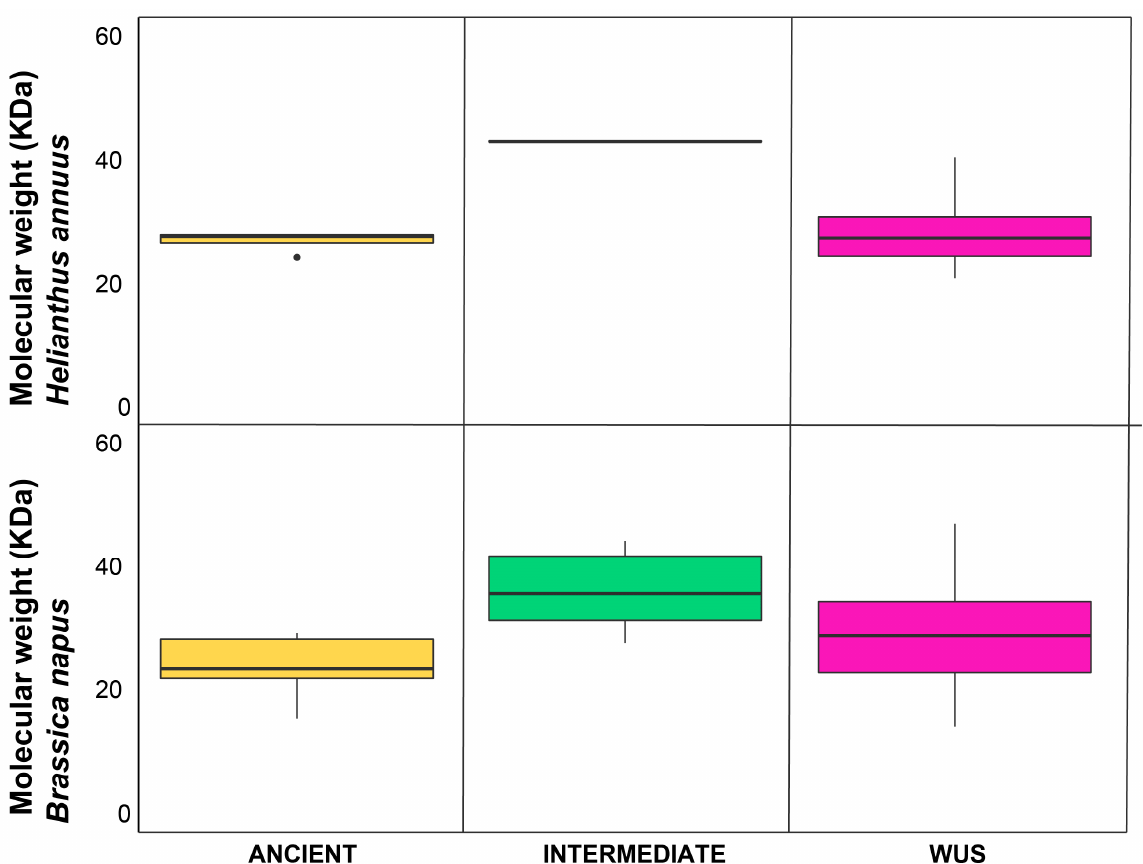
Figure 3. Boxplot of molecular weight for ancient (yellow), intermediate (green), and WUS (purple) HaWOX proteins compared to the corresponding clade of Brassica napus [28]. The black line represents the median value per each clade. Black dots represents outlier values.